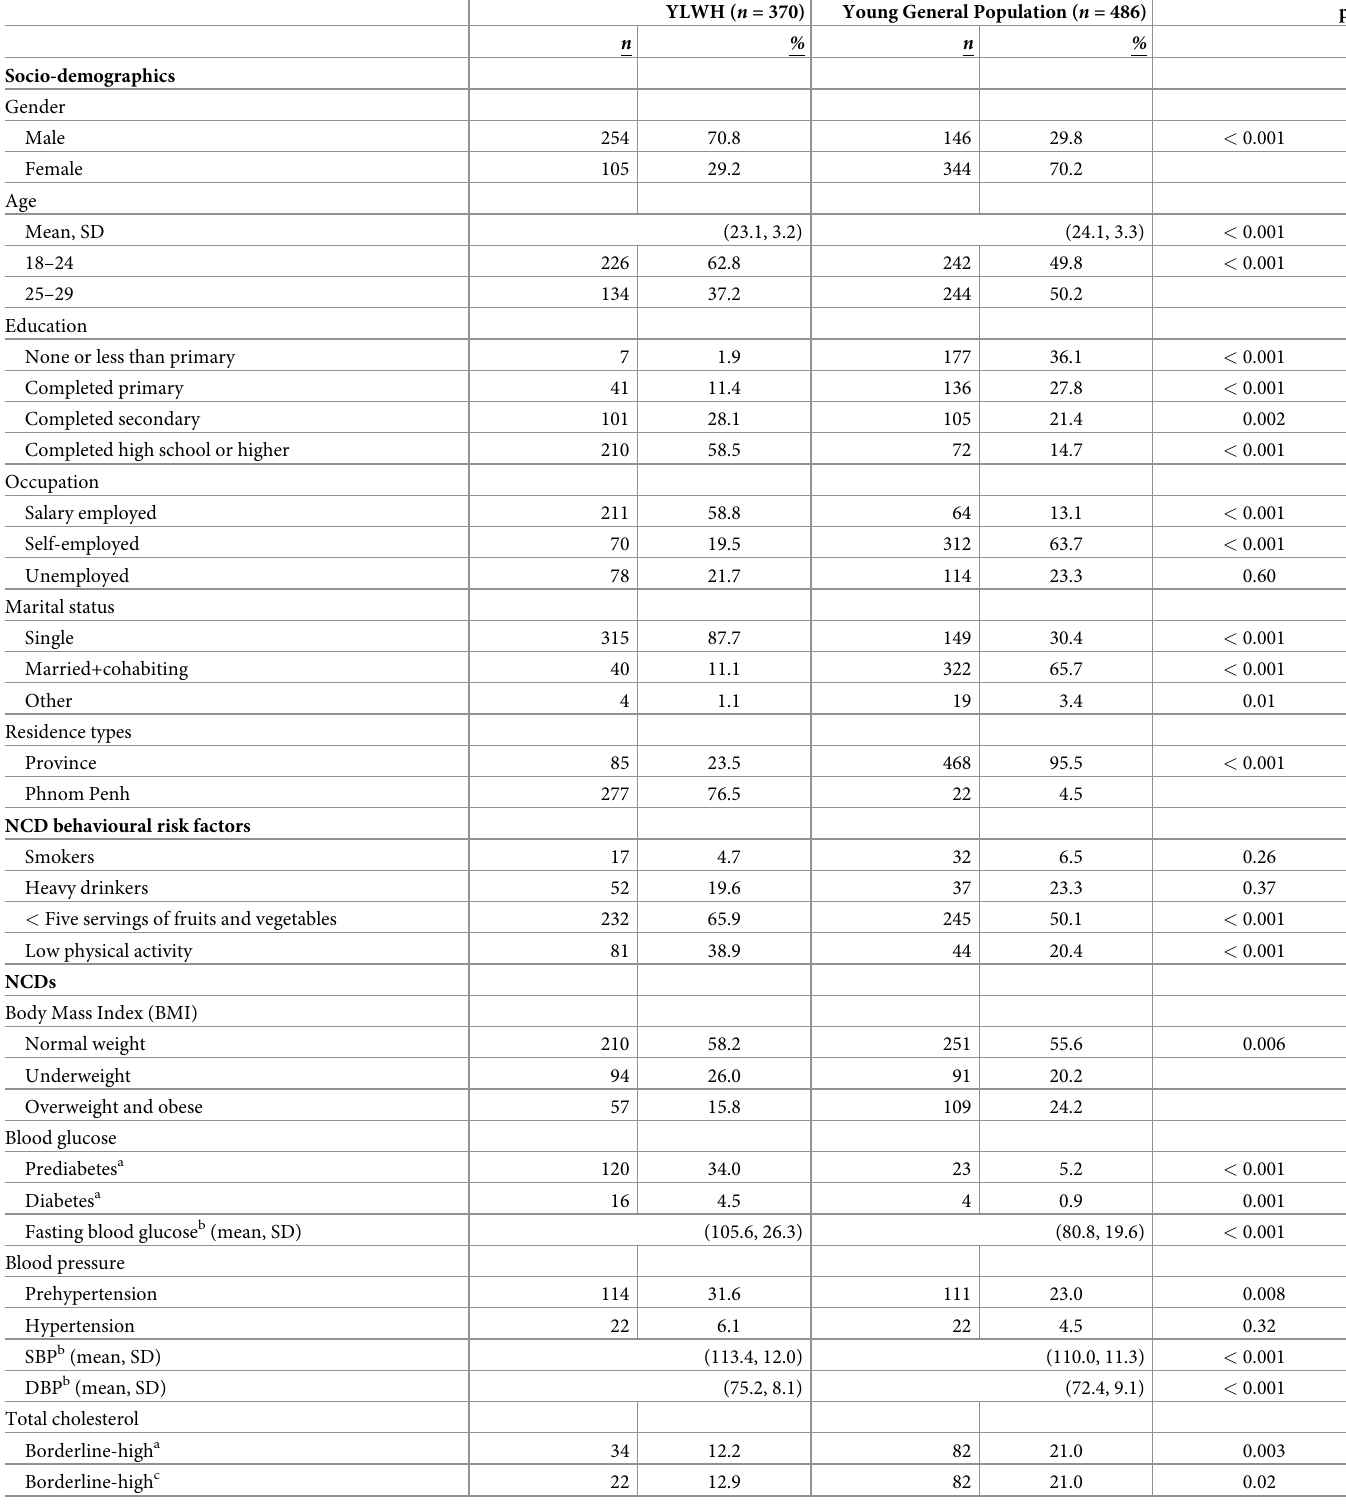
Table 1. Key characteristics of study participants, STEPS, Cambodia, 2016 and